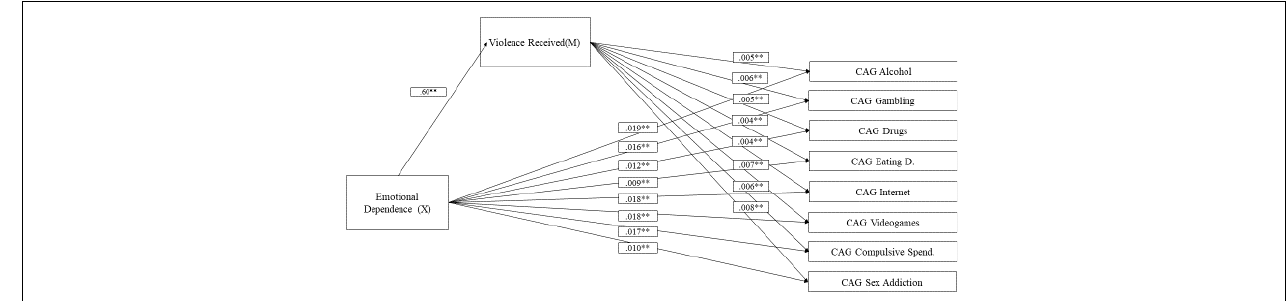
FIGURE 1 | Mediation model of intimate partner violence in the relationship between emotional dependence and addictive behaviours. CAGAlcohol, alcohol use disorder; CAGGambling, gambling disorder; CAGDrugs, drug use disorder; CAGEating D., eating disorder; CAGInternet, Internet addiction; CAGGaming, gaming addiction; CAGCompul.Spend, compulsive spending; CAGAdiccSex, sex addiction. ** p ≤